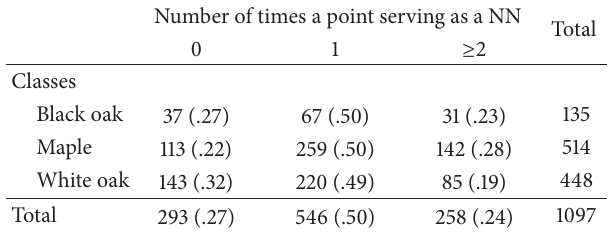
Table 14: The (reduced) 𝑄 -symmetry contingency table for the Lansing Woods data. The values in the parentheses are relative frequencies of the cells in each row with respect to the row sums.